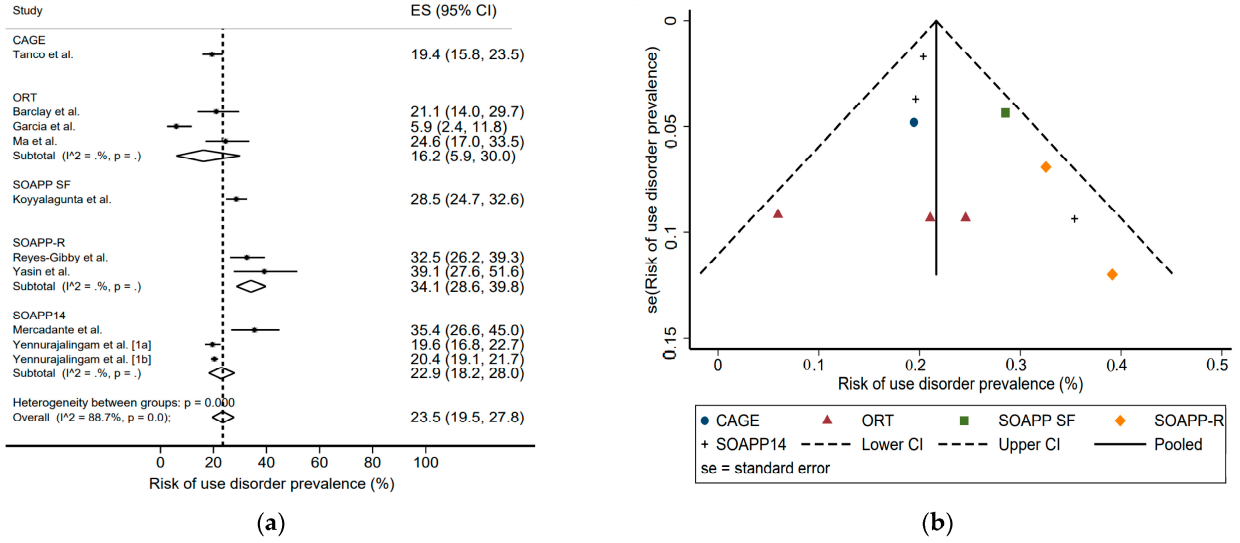
Figure 4. Risk of use disorder prevalence according to screening scale: ( a ) forest plot, ( b ) funnel plot [18,19,22,23,25–30].